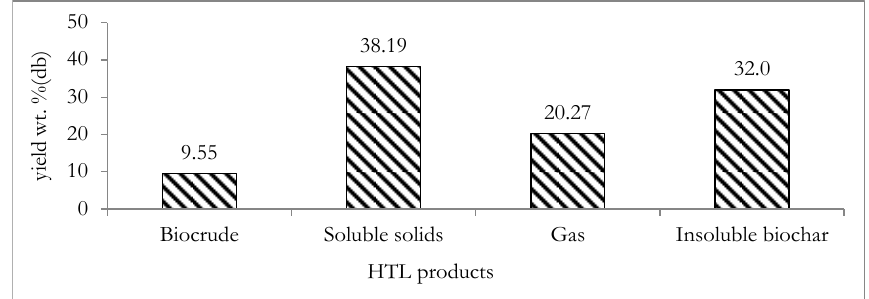
Figure 9. Theoretically determined yield of the major HTL products from the digestate feedstock: db indicates dry basis.